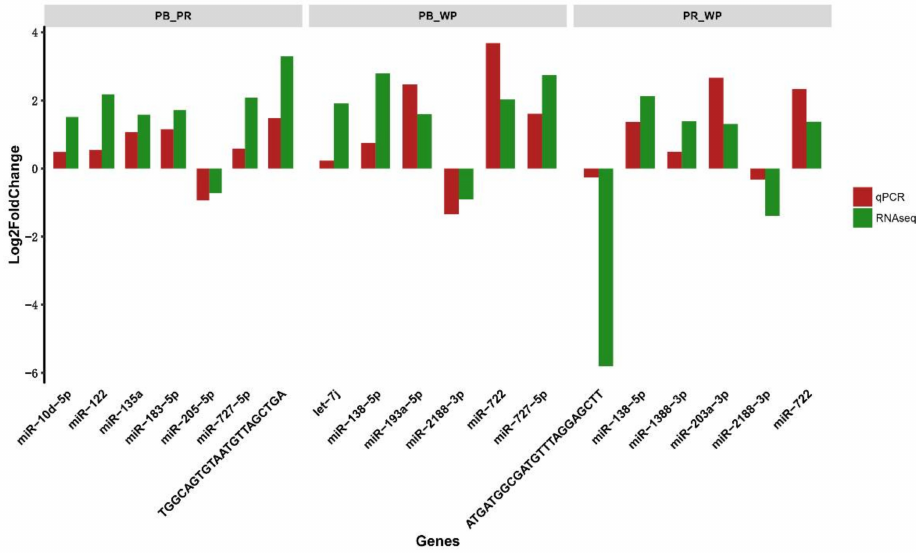
Figure 4. Comparison of relative expression levels of miRNAs between quantitative real-time polymerase chain reaction (RT-qPCR) and Illumina sequencing in three comparative groups of red